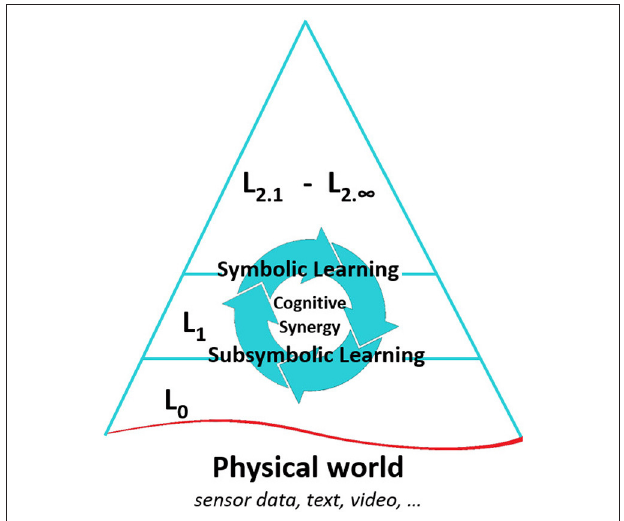
FIGURE 1 | Neurosymbolic metamodel and framework for artificial general